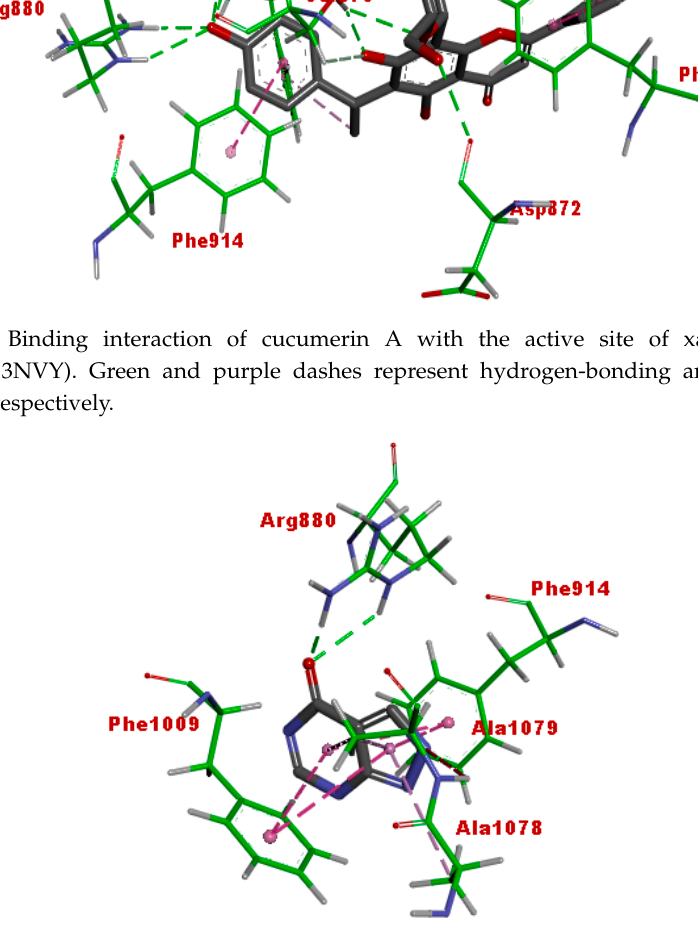
Figure 11. Binding interactions of allopurinol with the active site residues of xanthine oxidase (PDB code: 3NVY). Green and purple dashes represent hydrogen-bonding and hydrophobic interactions, respectively.